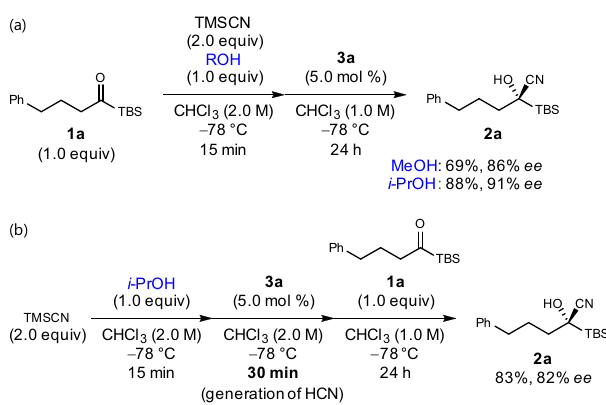
Fig. 4 Reactions with different procedures. a Optimized procedures. b Modi fi ed procedures.